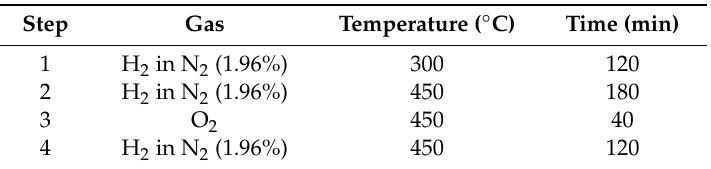
Table 2. Annealing condition.